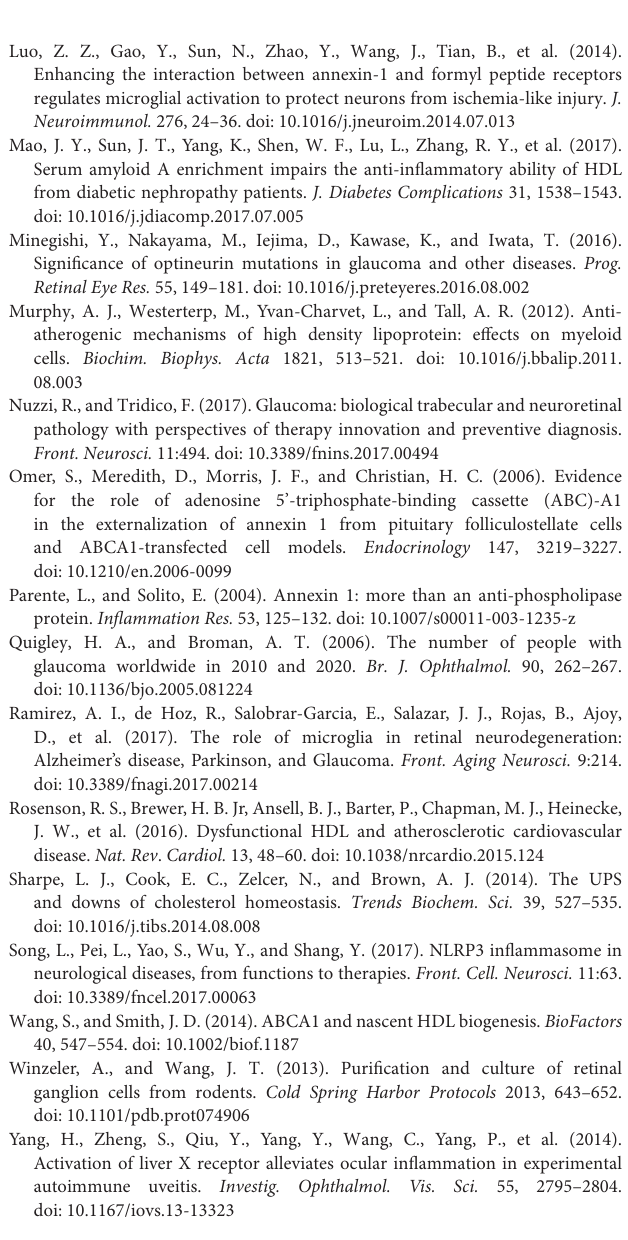
Supplementary Figure 1 | The expression of ABCA1/ANXA1 in full retinal slice after IR. (A) Representative immunofluorescence images of ANXA1 expression in ischemic retina slices. GCL: ganglion cell layer; INL: inner nuclear layer; ONL: outer nuclear layer. (B) Immunofluorescence analysis showing the expression of ABCA1 in a full retina slice after